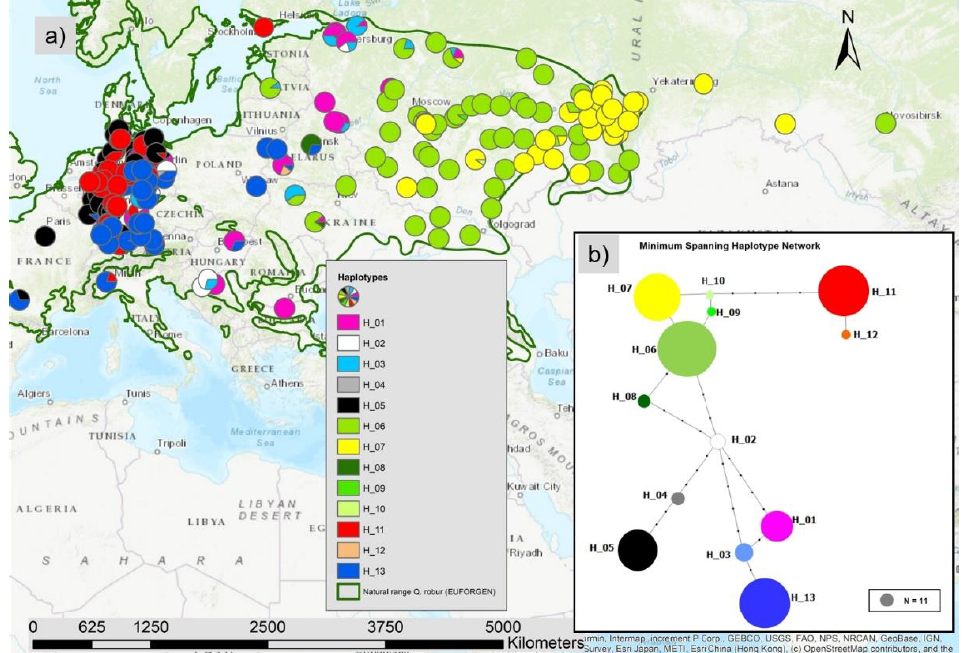
Figure 2. (a) Map with the spatial distribution of the 13 different haplotypes and ( b ) haplotype network constructed with the minimum spanning method (small black dots represent the number of mutations, the diameter of the colored dots is proportional to the absolute number of sampled individuals with the haplotype).